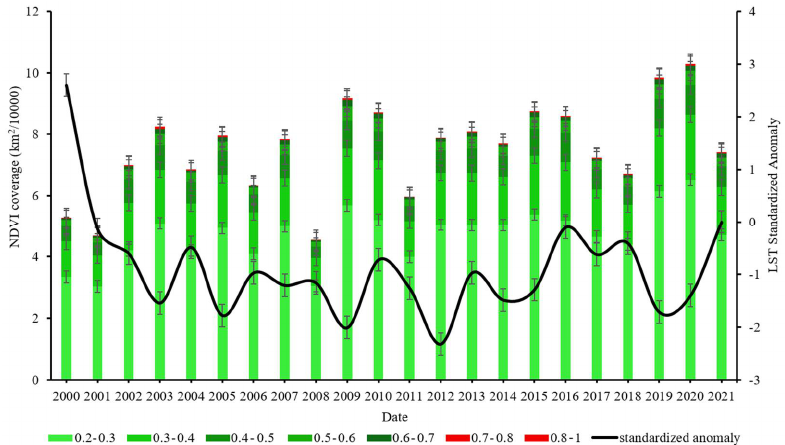
Figure 10. The relationship between time series of yearly vegetation coverage variations and standardized LST anomaly in Afghanistan in the period 2000–2021.